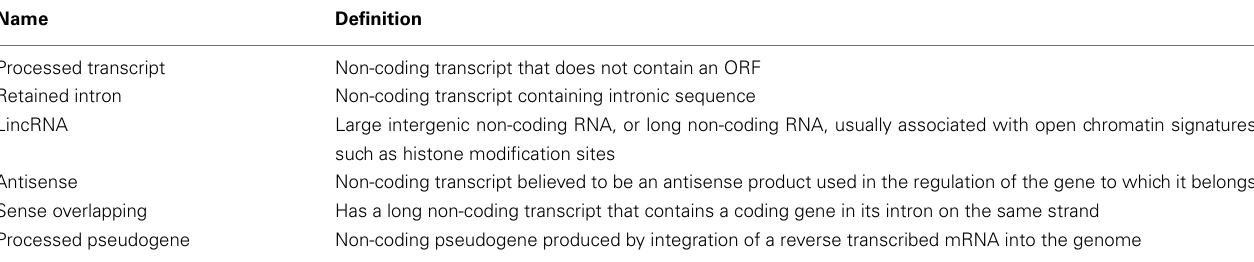
Table 2 | Definitions of Ensembl “Transcript Biotype” annotations for non-coding transcripts found differentially expressed.